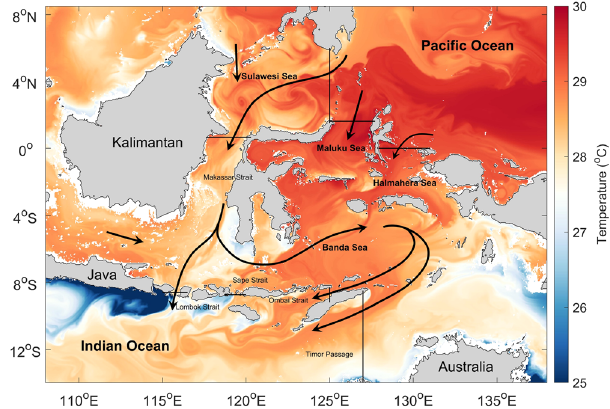
Fig. 1 | A snapshot of the sea surface temperature in (°C) at 25m depth at the end of the simulation. Sections across the major entrance and exit straits and passages on the Indian and Paci fi c Ocean sides of the region used for the total energy fl ux calculation in Table 1 are shown by the solid black